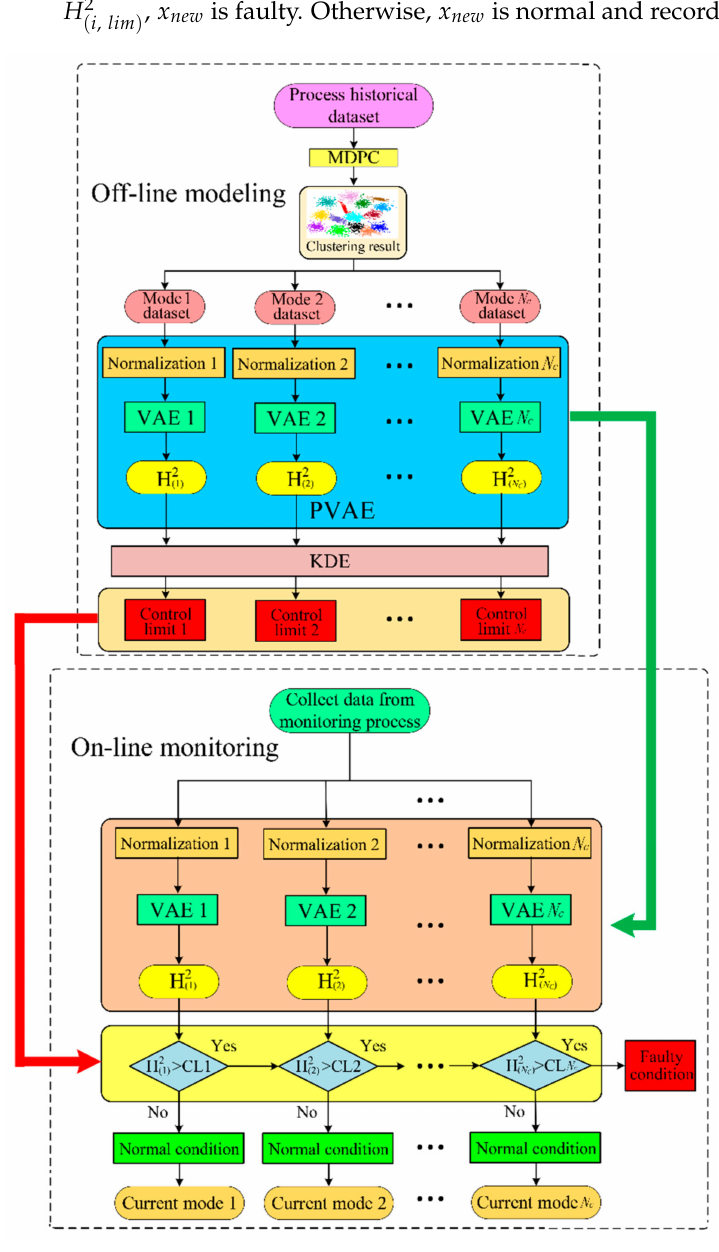
Figure 6. The procedure of MDPC-PVAE-based multimode process